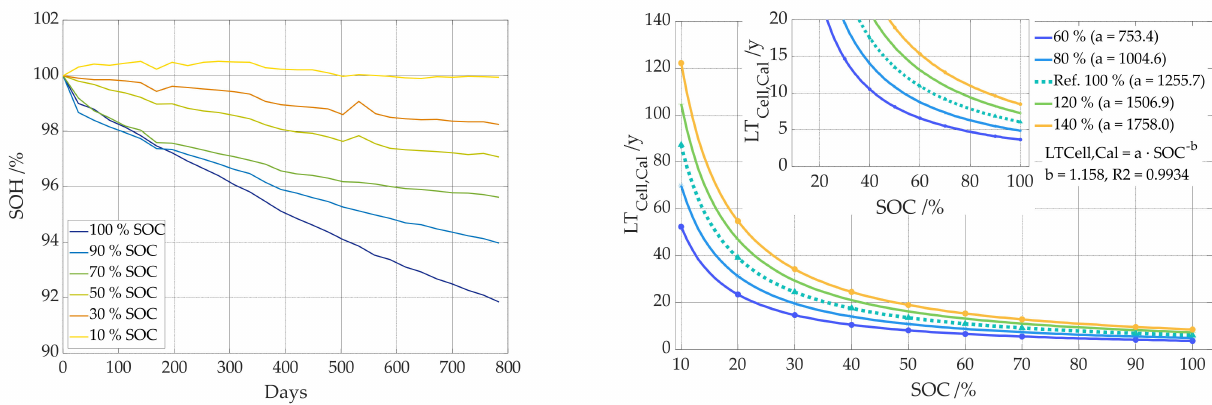
Figure 7. Result of calendar aging tests at 25 ◦ C at different SOCs (10%, 30%, 50%, 70%, 90% and 100%) of a 53 Ah NMC cell ( left ). Functional relationship between the lifetime in years until EOL at different SOCs ( right